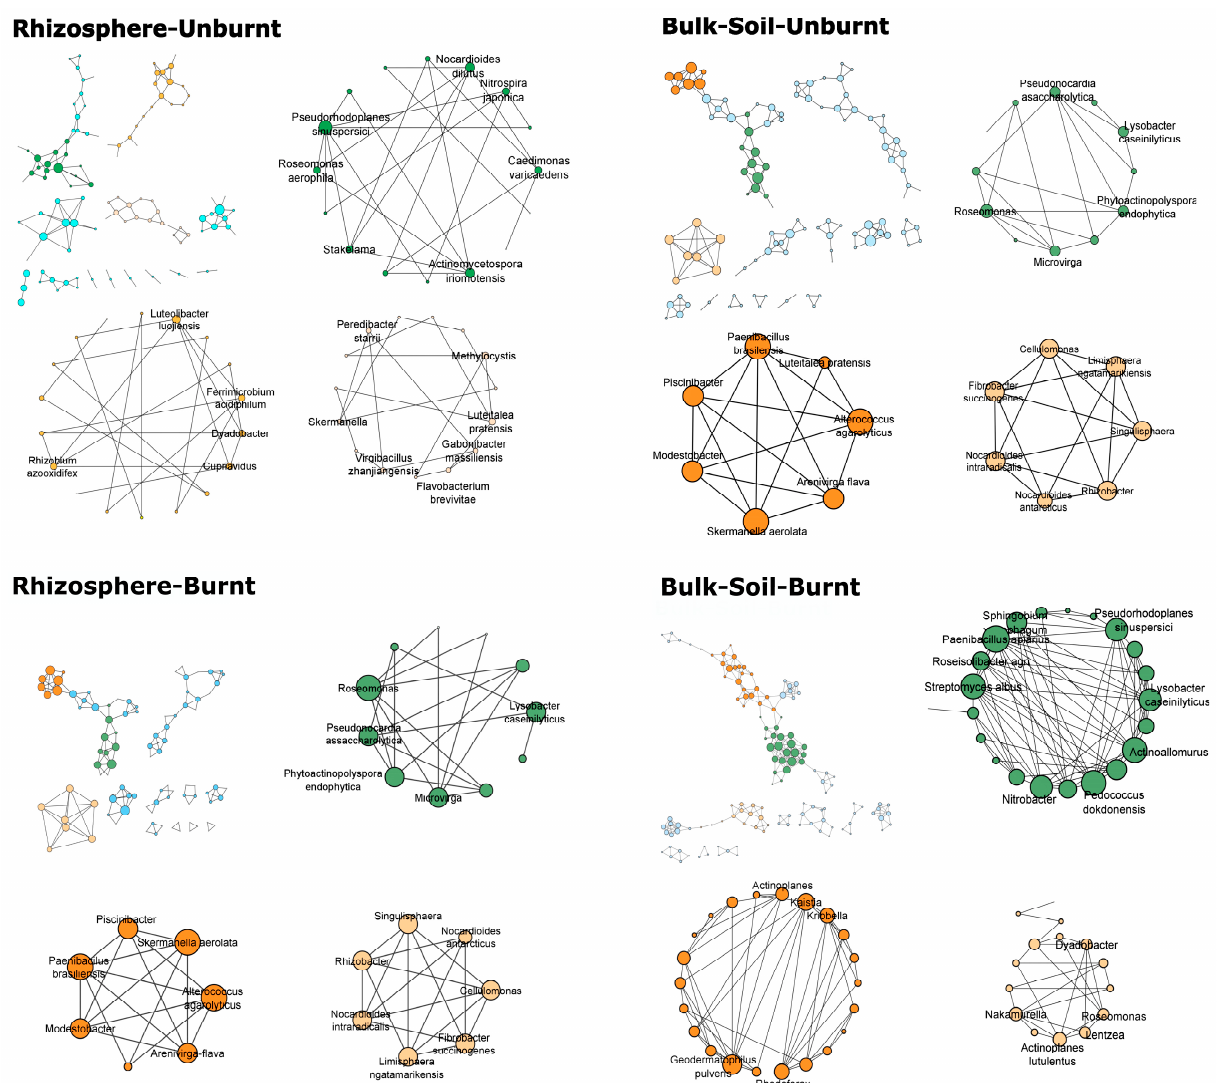
Figure 1. Co-occurrence networks among bacterial taxa sampled in the rhizosphere and bulk soil in burnt and unburnt soils. The size of nodes corresponds to their degree of centrality, and different colors correspond to different modules. In each plot type, the outline of the overall network is presented at the left upper corner, followed by the three biggest modules as these are revealed by the Girvan–Newman algorithm.